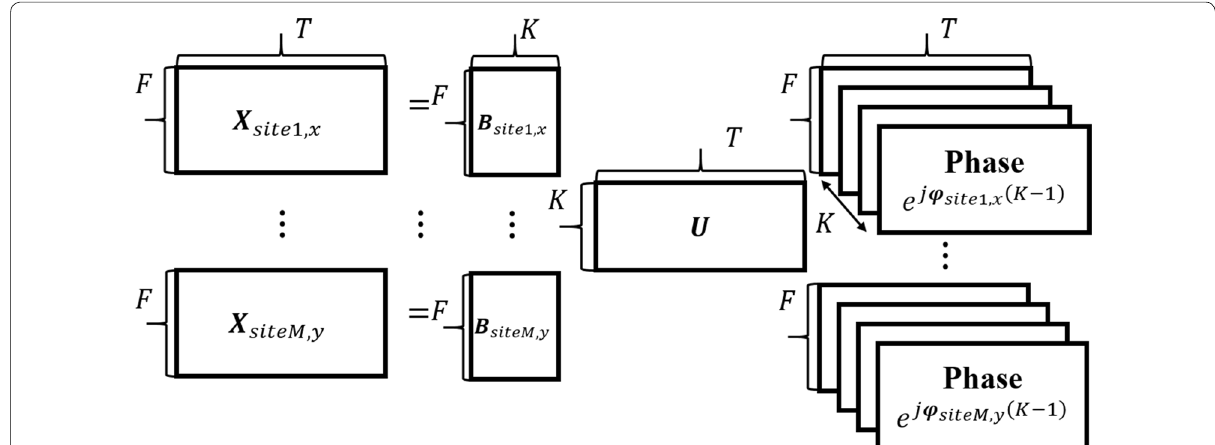
Fig. 1 Model of MC‑NMF. F , T , and K denote number of frequencies, time windows, and Basis vectors, respectively. X denotes observed spectrograms, B denotes Basis vectors, and U denotes